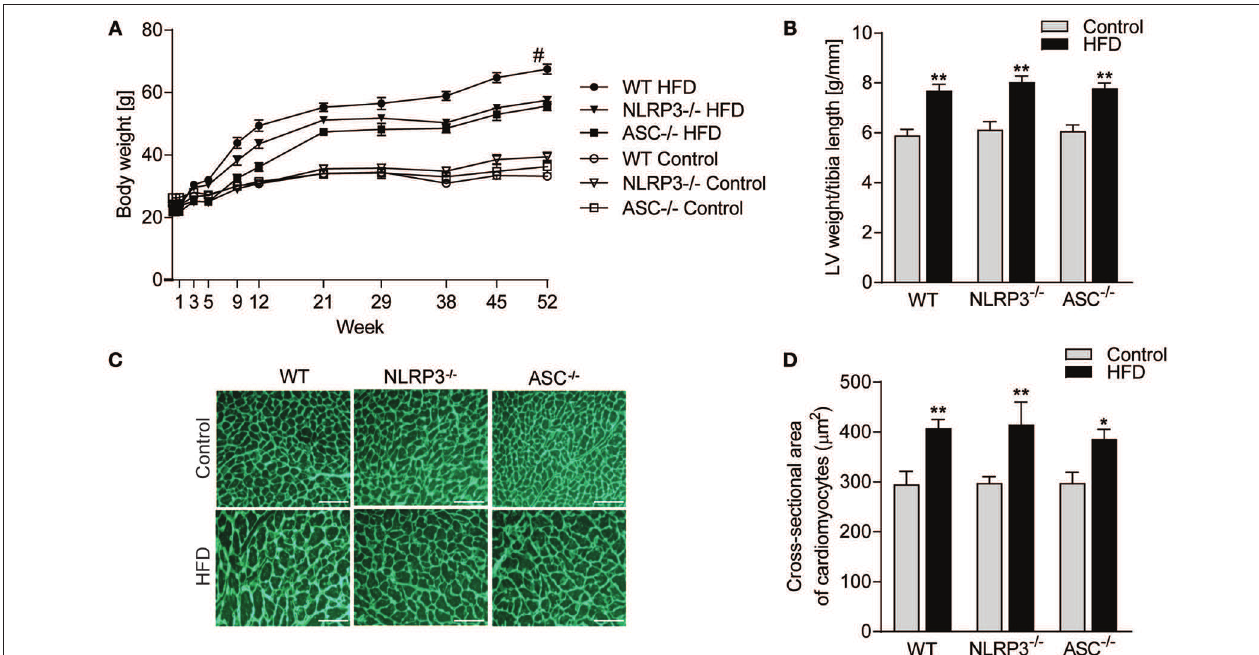
FIGURE 1 | NLRP3 inflammasome does not affect obesity-induced LV hypertrophy. WT, Nlrp3 − / − , and Asc − / − ( Pycard − / − ) male mice were exposed to high fat diet (HFD; 60 cal% fat) or control diet for 52 weeks. (A) Comparison of bodyweight gain in mice on control or HFD during the 52 weeks [WT: Control, n = 12; HFD, n = 12, Nlrp3 − / − : Control, n = 11; HFD, n = 12, and Asc − / − ( Pycard − / − ): Control, n = 10; HFD, n = 12]. (B) Left ventricle (LV) weight normalized to tibia length weeks [WT: Control, n = 11; HFD, n = 11, Nlrp3 − / − : Control, n = 8; HFD, n = 8, and Asc − / − ( Pycard − / − ): Control, n = 10; HFD, n = 6]. (C) Representative images of wheat germ agglutinin (WGA) stained LV sections [WT: Control, n = 8; HFD, n = 9, Nlrp3 − / − : Control, n = 7; HFD, n = 7, and Asc − / − ( Pycard − / − ): Control, n = 8;